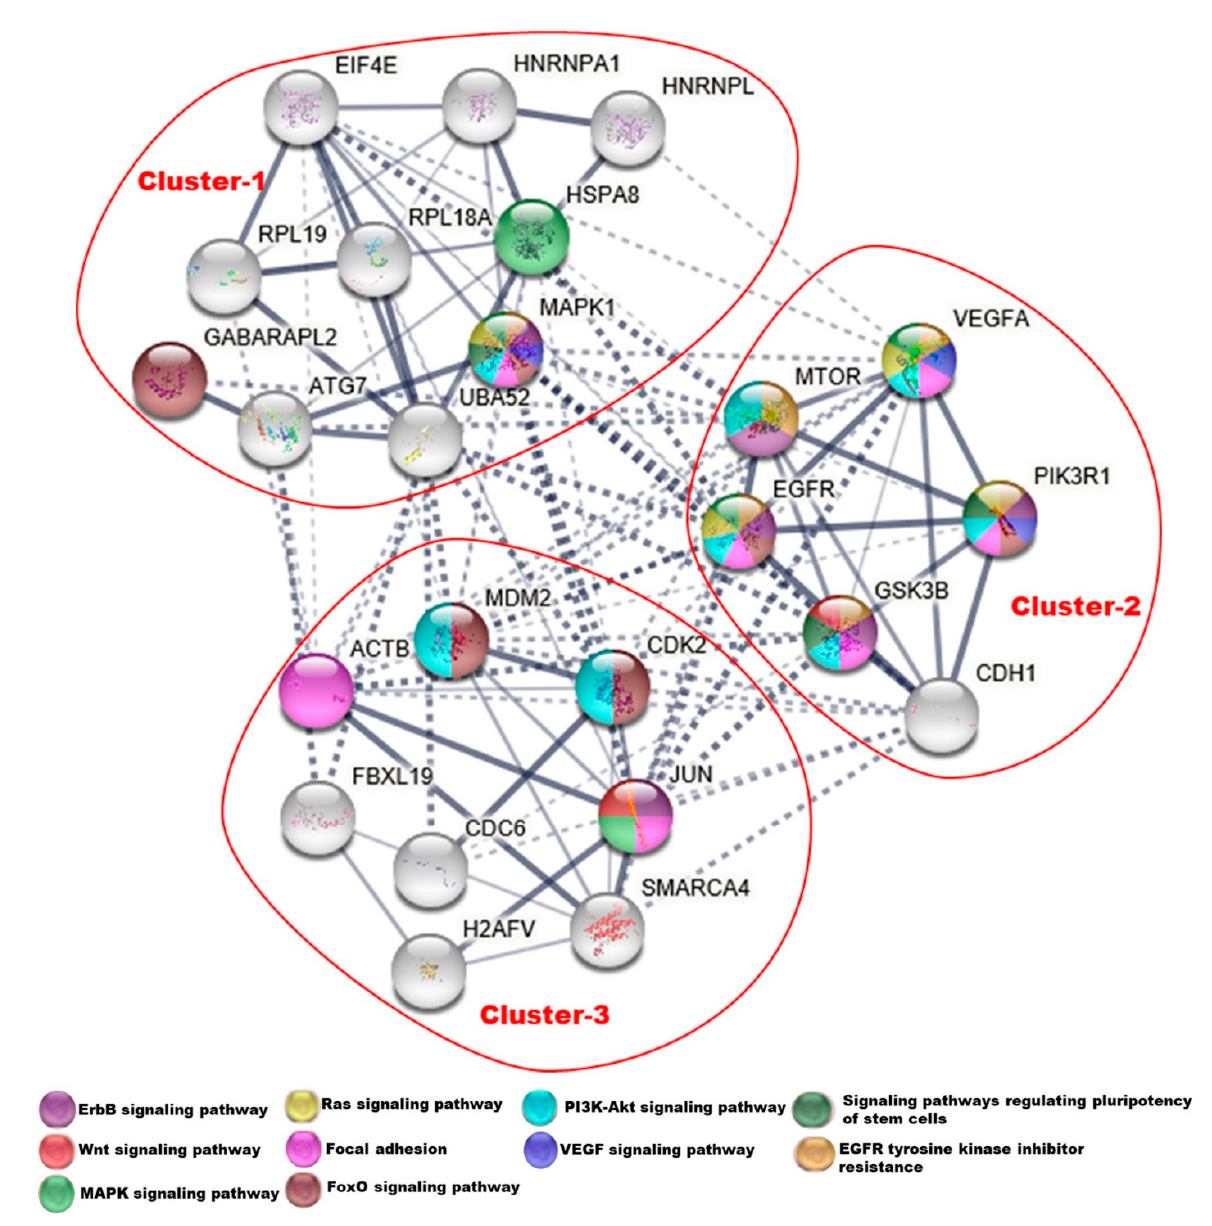
Figure 4. Protein–protein interaction network between hub proteins from targets of the 5 miRs generalizing to COPD exacerbations. Node coloration indicates membership in 10 significant asthma-related pathways. Dotted, light, and thick dark color line showing low, medium, and high edge confidence score, respectively.